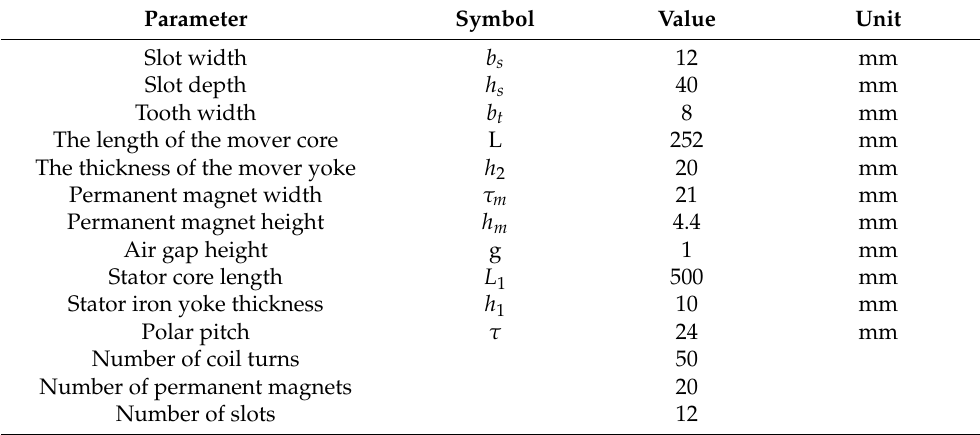
Figure 2. Winding arrangement order: ( a ) Electrical potential star chart of slot; ( b ) Winding arrangement order. Table 1. PMLSM parameters.